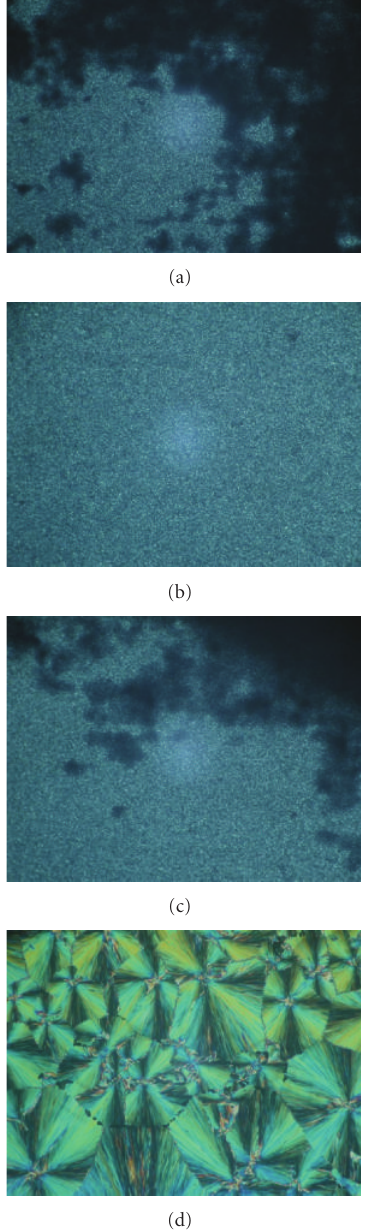
Figure 8: Polarized optical micrographs of cholesteryl nonanoate acid taken during cooling from the isotropic phase at (a) 90.2 ◦ C, (b) 80.7 ◦ C, (c) 69.9 ◦ C, and (d) 25 ◦ C (20min annealing).